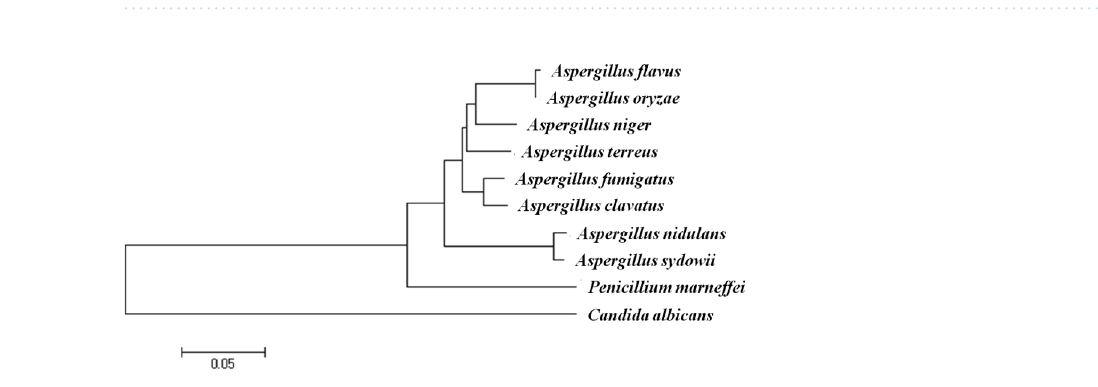
Figure 2. Phylogenetic tree was created using ITS